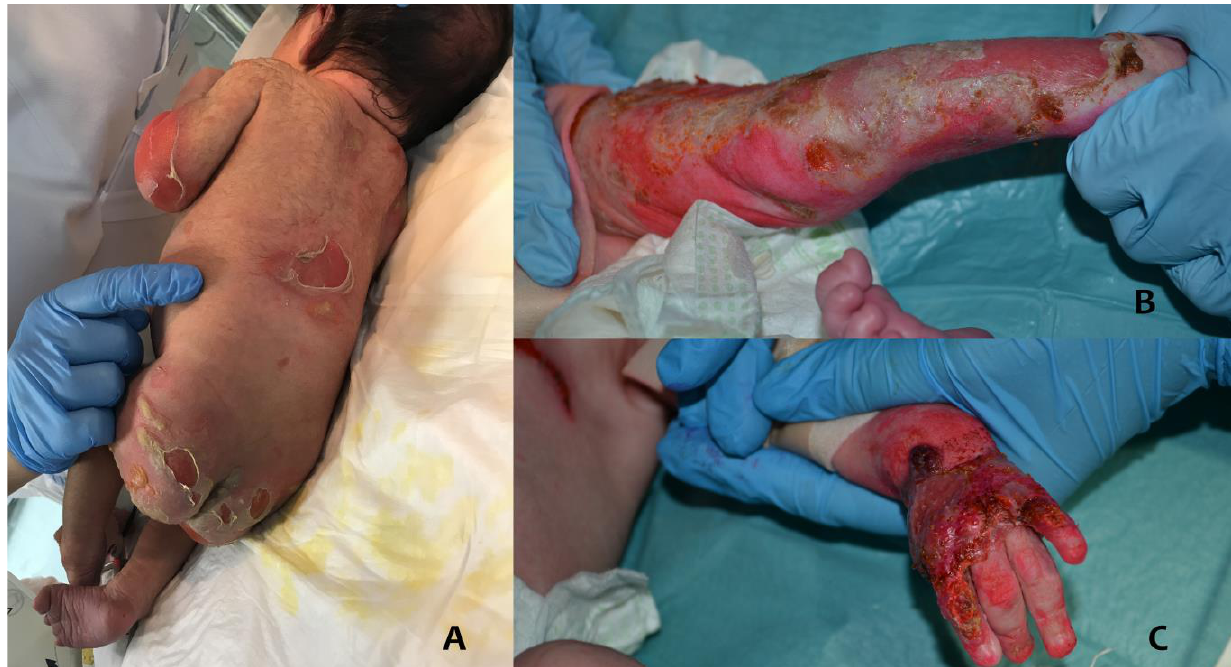
Figure 3. A case of a neonate with severe Junctional Epidermolysis bullosa ( A ), with Staphylococcal skin infection of the left leg ( B ) and the left hand ( C ).